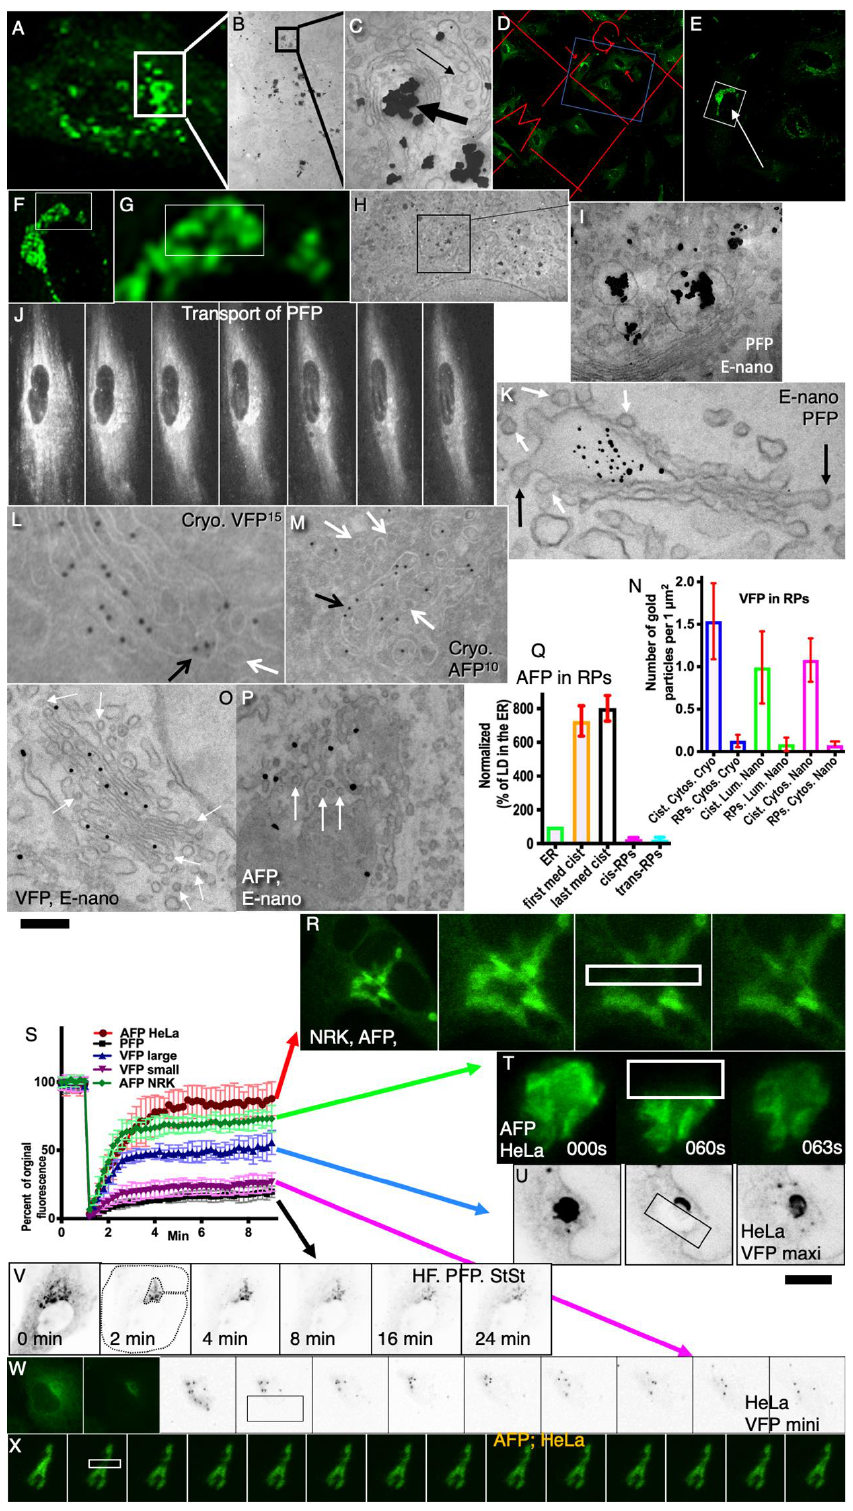
Figure 1. Characterization of the cargoes selected for the present study. Human fibroblasts ( A – K ) and HeLa cells ( L , M , O , P ) were transfected with PFP ( A – K ), VFP ( L , O ), or AFP ( M , P ), incubated at 32 °C for 16 h, and examined under immune fluorescence ( A , D – G , J , R , T – X ) or labeled with the antibody against GFP for electron microscopy (EM) ( B , C , H , I , K – M , O , P ). ( A – I ) Correlative light– electron microscopy (CLEM) of human fibroblasts transfected with PFP. At the